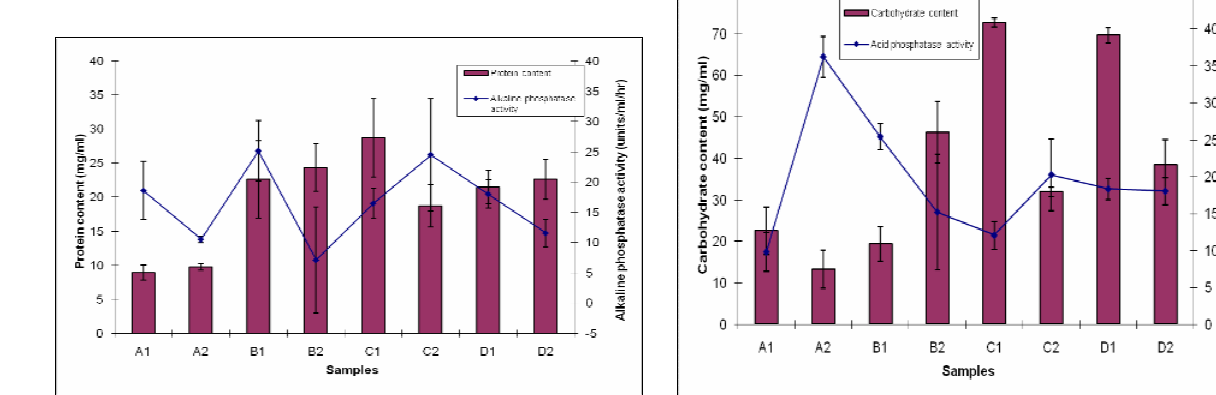
Fig. 1. Protein content in relation to alkaline phosphatase activity of the raw milk samples